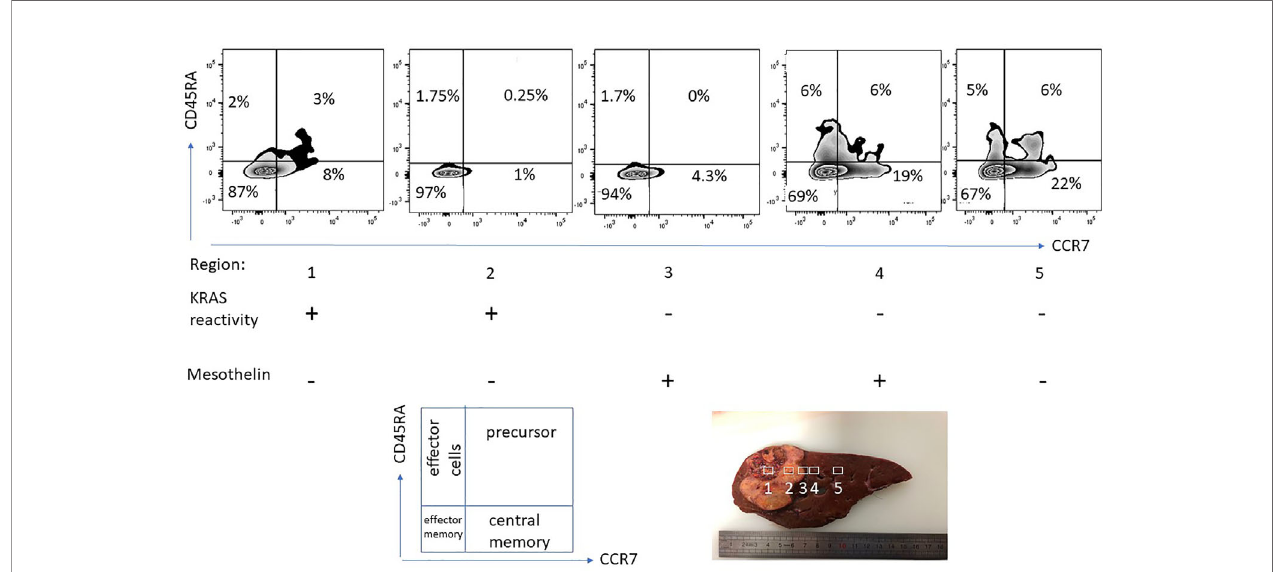
FIGURE 4 | T-cell phenotype and functional-spatial differences. TIL were expanded from different regions from a pancreas cancer lesion metastatic to the liver, 5 regions were harvested in different proximity to the tumor center. Note the different homing/maturation phenotype based on CD45RA/CCR7 expression, central memory T-cells in the tumor periphery. Thus, the quality of the T-cell response (to neoepitopes) is also associated with the immune cell maturation status. Reactivity to (mutant) KRAS or mesothelin was tested by pre-incubation of TIL for 5 days followed by IFN-gamma production analysis. Exclusive KRAS recognition in the tumor center versus mesothelin recognition in the tumor periphery and in macroscopically cancer-negative tissue demonstrating that the selection of neoepitope speci fi c T-cells depends on the anatomical